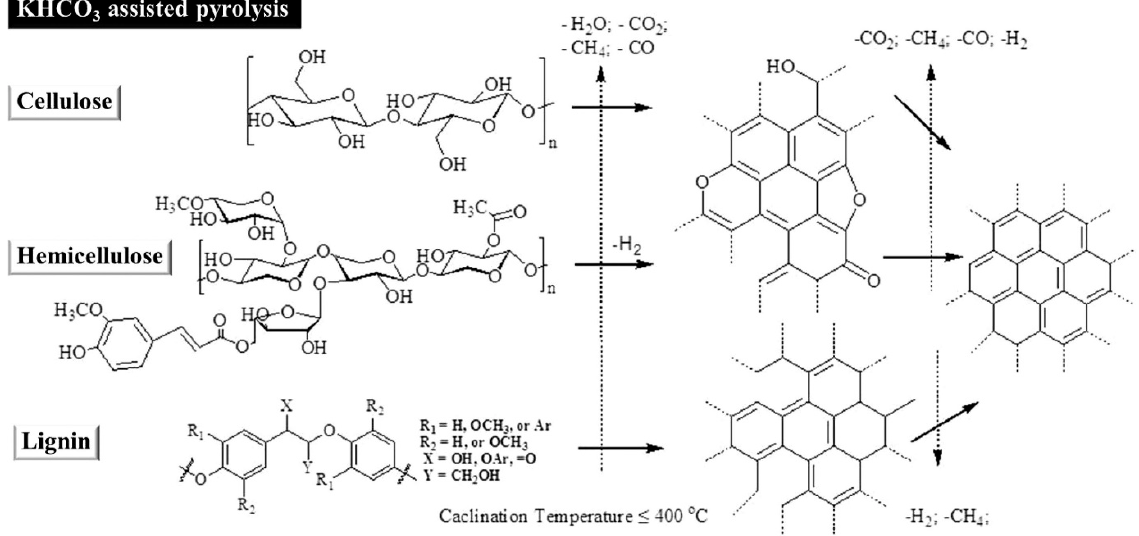
Figure 1. Possible carbonization routes of cellulose, hemicellulose and lignin in the presence of KHCO 3 (reproduced from [40], with permission from American Chemical Society, 2016).